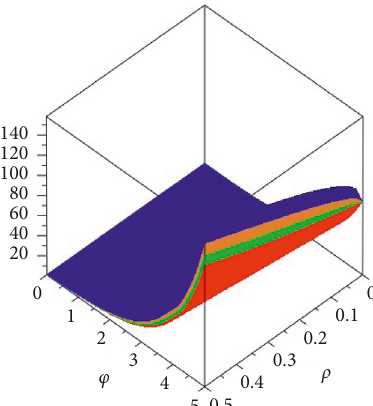
Figure 7: The graph shows different fractional orders of δ .